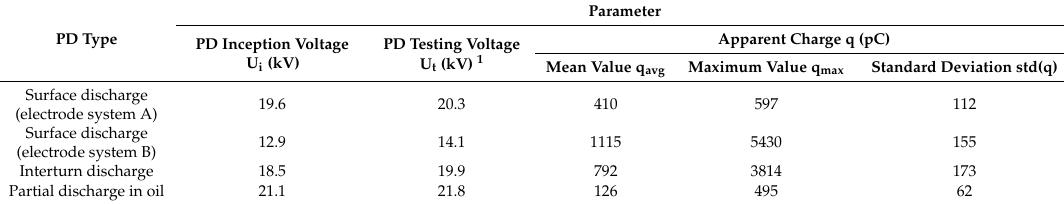
Figure 10. Schematic diagram of the measurement setup: U = high-voltage supply; Z = short-circuit current limiting resistor; AE = four-channel acoustic emission measuring system; P = preamplifier; S = acoustic emission sensor; TT = oil-filled transformer tank; PD = electrode system for partial discharge generation; C = coupling capacitor; CD = coupling device (measuring impedance); CC = connecting cable; M = conventional partial discharge measuring instrument; PC = computer. Table 2. The electrical parameters of the investigated types of partial discharges.